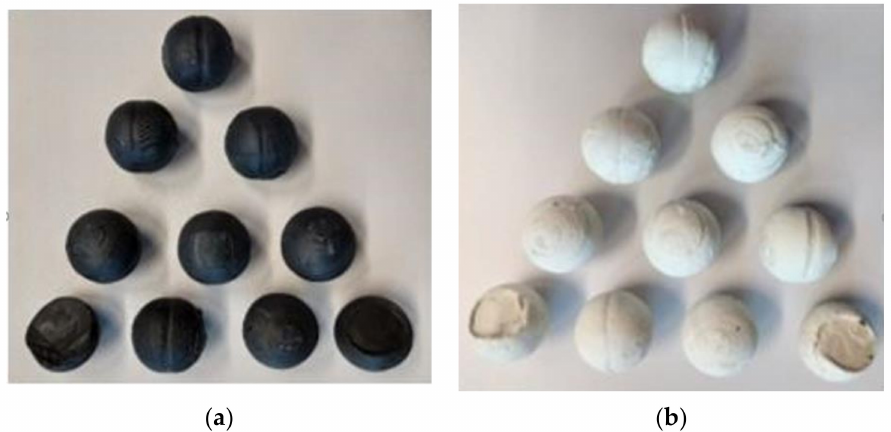
Figure 10. Samples made on type first tools: ( a ) black plasticine; ( b ) white plasticine.